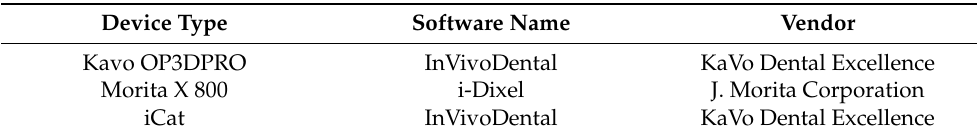
Table 1. The CBCT devices and software used for imaging and analysis.